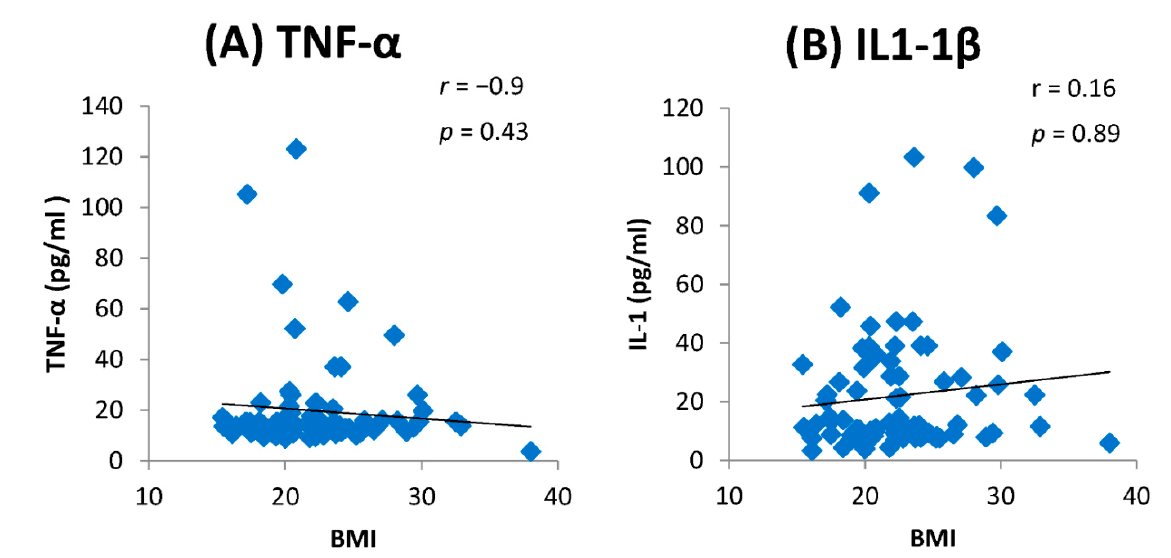
Figure 7. Correlation between St George Respiratory Questionanire (SGRQ) total score and levels of ( A ) TNF- α (pg/mL) and ( B ) IL-1 β (pg/mL) among the cases.